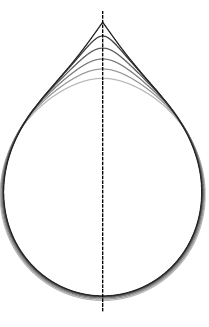
Figure 7. Cross-sections of the geometries described by the embedding function (5.5); these should be rotated around the dotted axis to generate the corresponding deformed spheres. From gray to black, we show (cid:15) = 0 to 1 in intervals of 0 . 2 ; the (cid:15) = 1 embedding exhibits a conical defect at the pole.